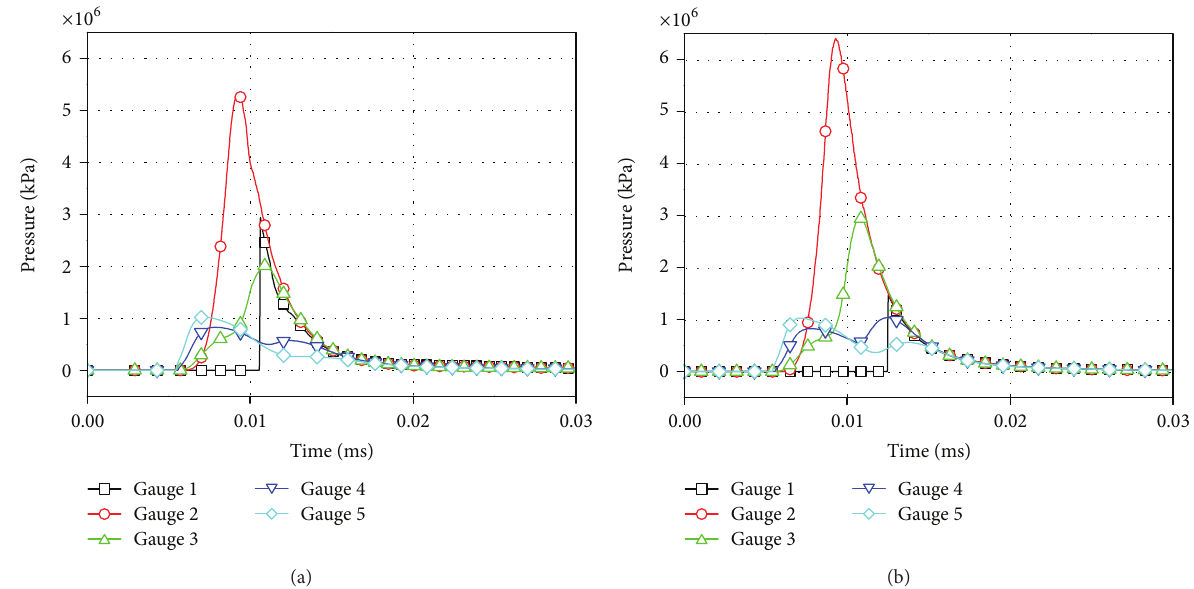
Figure 11: Pressure-time history of gauges placed in air field along the axis of cylindrical charge for the test plates. (a) Sandwich panel (case number S20-1) and (b) solid plate (case number